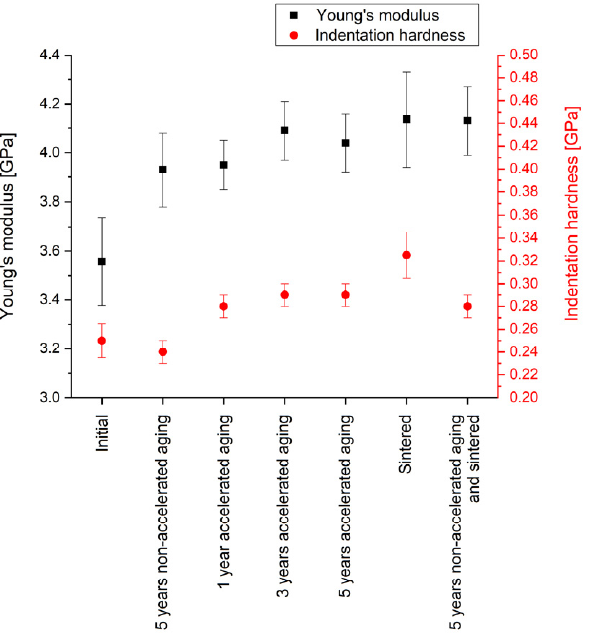
Figure 8. Results of the nano-indentation measurements for the Young’s modulus and the indentation hardness of Parylene C. The error bars represent the standard deviation.